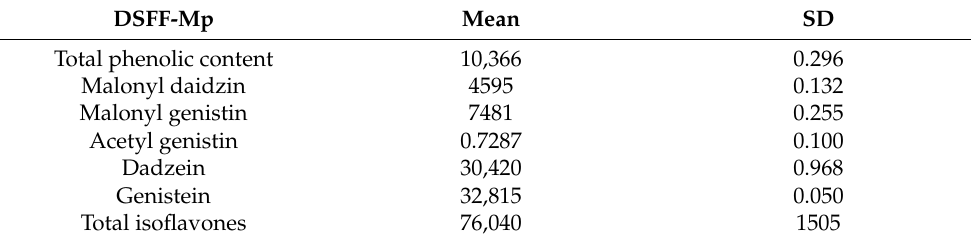
Table 2. DSFF-Mp total phenolic content.